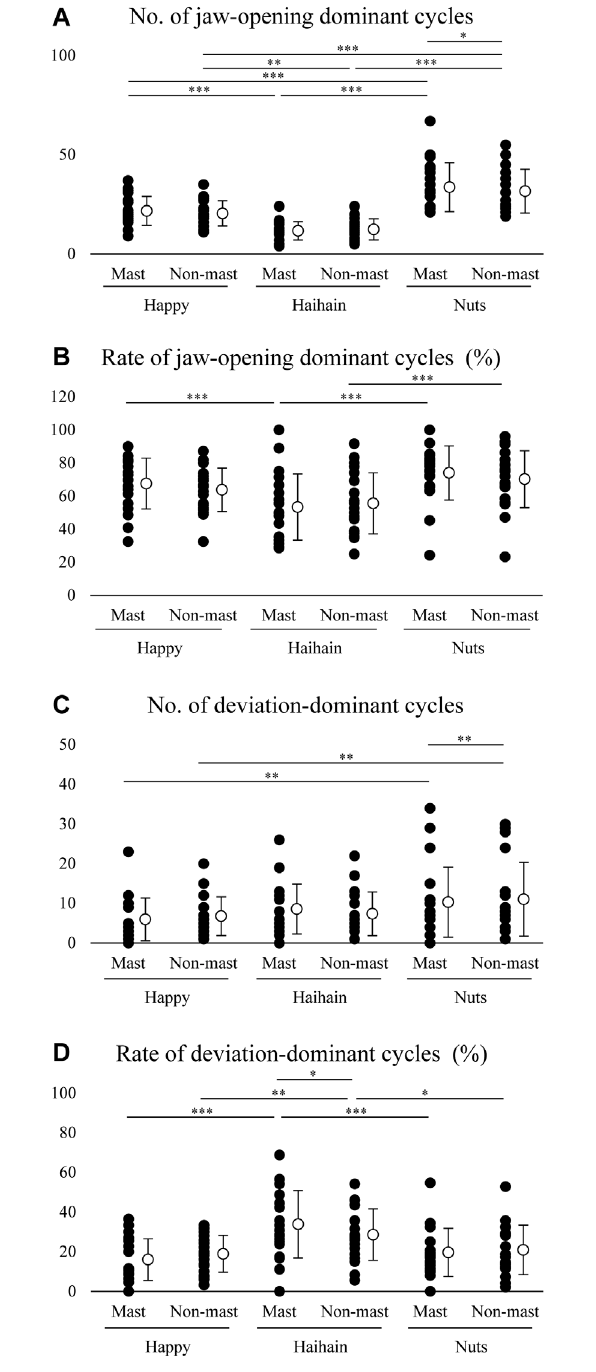
FIGURE 8 | Number and rate of jaw-opening dominant cycles and deviation-dominant cycles. Open circles indicate mean values. (A) Signi fi cantly higher number of jaw-opening dominant cycles during Nuts mastication than Haihain mastication. This difference was observed betweenthe masticatory(Mast) and non-masticatory sides (Non-mast) during Nuts mastication. Food effect, p < 0.001; Food × Side effect, p = 0.002. (B) Rate of jaw-opening dominant cycles was signi fi cantly higher during Nuts and Happy mastication than Haihain mastication on the masticatory side,